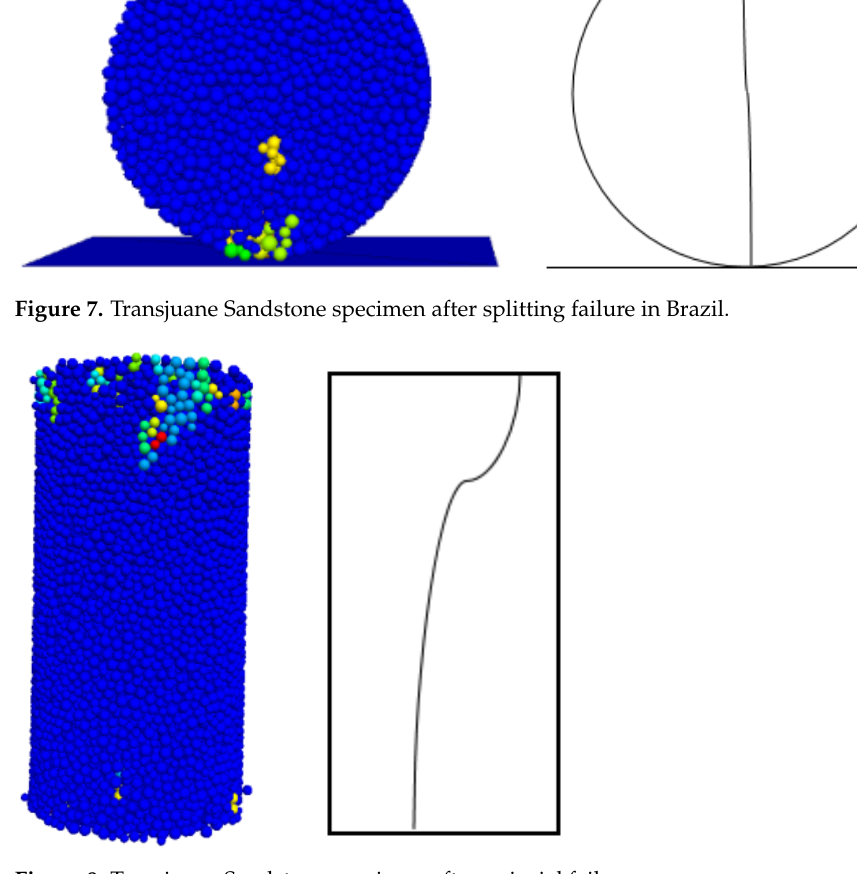
Table 6. Initial determination of microscopic parameters.